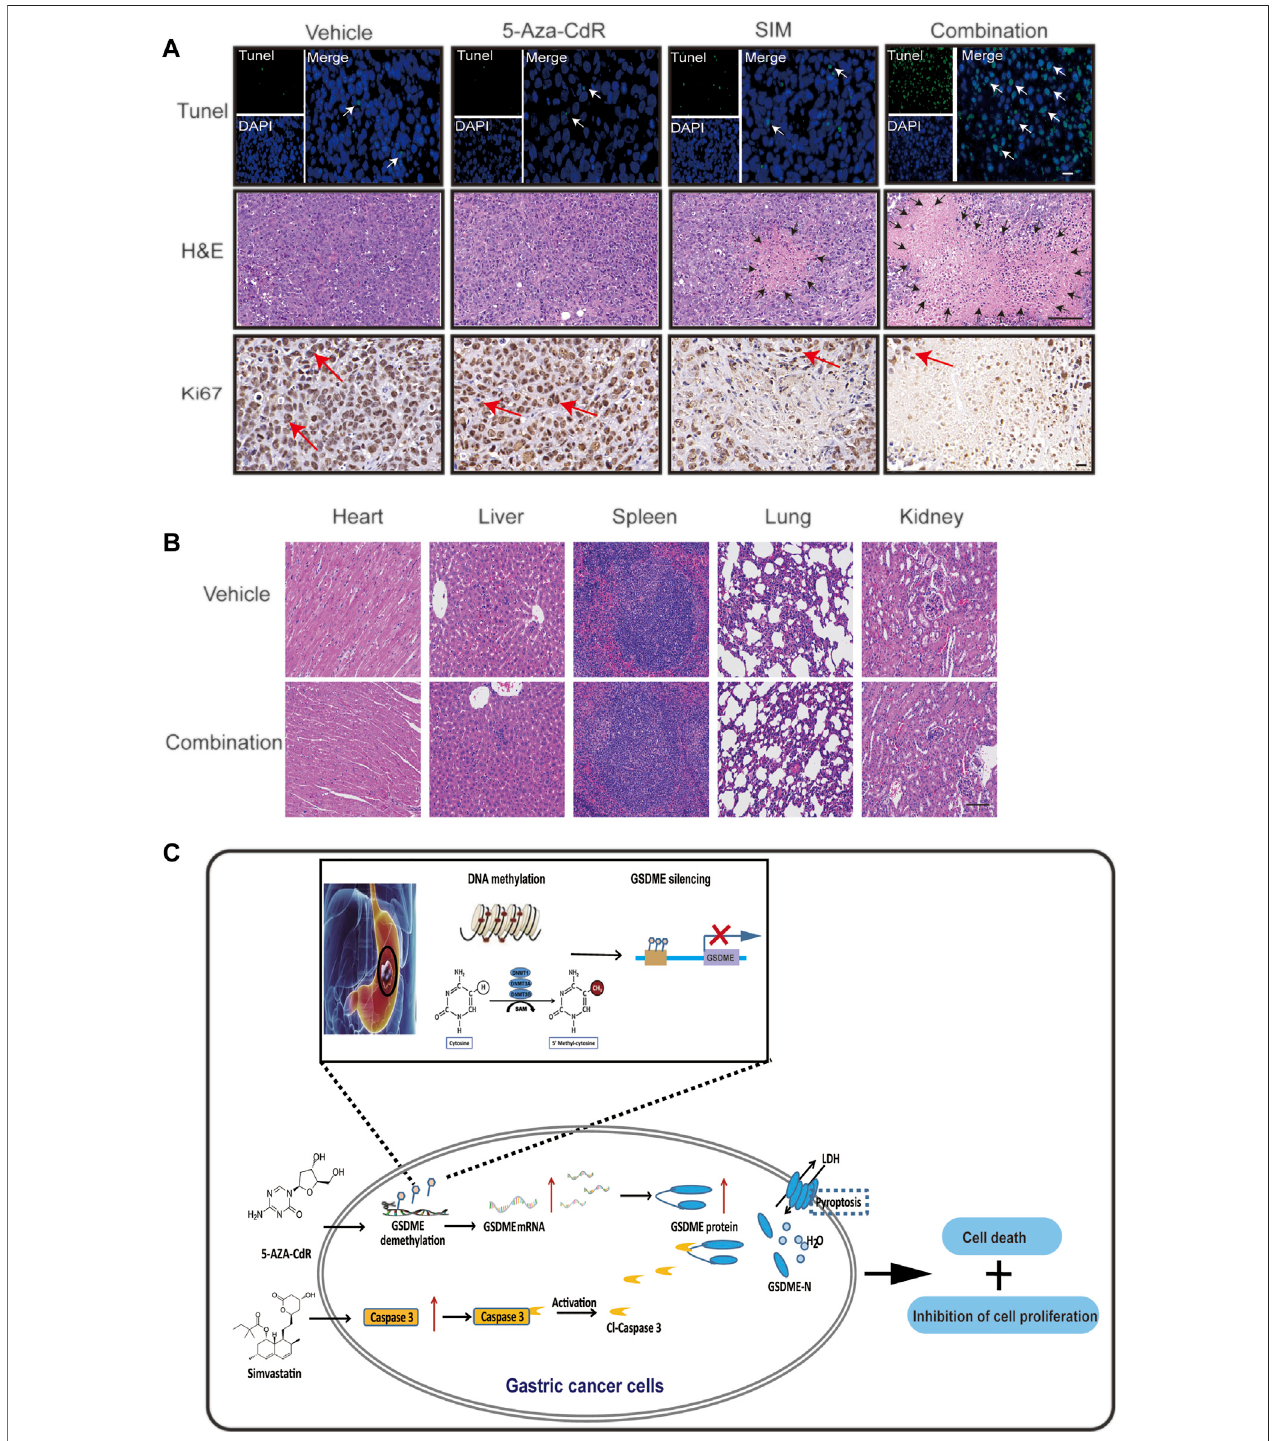
FIGURE8| 5-Aza-CdRpromotesSIM-inducedGCpyroptosis via caspase3/GSDMEpathway invivo . (A) TUNEL,H&EstainingandKi67IHCofxenografttumour slicesafterindicatedtreatment.TUNELscalebar:20 µm.Whitearrows:TUNELpositivecells;H&Escalebar:100 µm.Blackarrows:theareasofnecrosis;IHCscalebar: 20 µm. Red arrows: Ki67-positive cells. (B) HE staining of heart, liver, spleen, lung, and kidney tissues in each group; scale bar: 100 µm. (C) Schematic diagram to illustrate the mechanisms underlying the induction of pyroptosis in GC by a combined treatment of SIM with 5-Aza-CdR via caspase-3/GSDME activation.